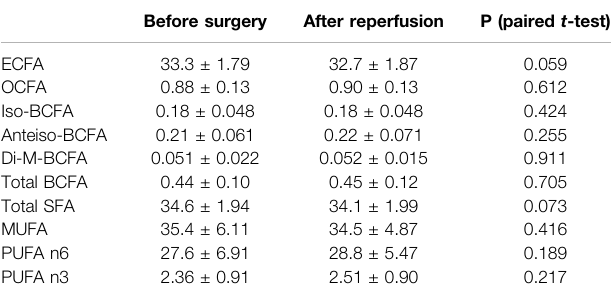
TABLE 2 | Levels of FA subfamilies from serum lipids in patients with end-stage liver dysfunction before liver transplantation and after reperfusion (mean % ±